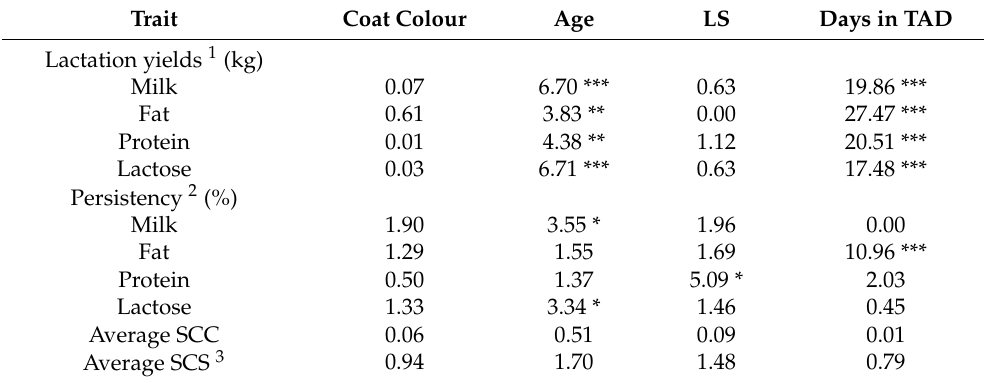
Ewe age affected the lactation persistency of milk and lactose yields, litter size affected the lactation persistency of protein yield, and milking frequency strongly affected the lactation persistency of fat yield with a large F-value (10.96). Late-lambing ewes that were not milked TAD in early lactation had a significantly higher lactation persistency of fat than early-lambing ewes (Table 6). Coat colour had no significant effect on any trait. None of the factors significantly affected the somatic cell score. Table 4. F-values for effects of ewe coat colour, ewe age, litter size (LS), and days in twice-a-day (TAD) milking on milk production traits in Dairymeade sheep in the production season of 2021–2022. Trait Coat Colour Age LS Days in TAD Lactation yields 1 (kg) Milk 0.07 6.70 ***